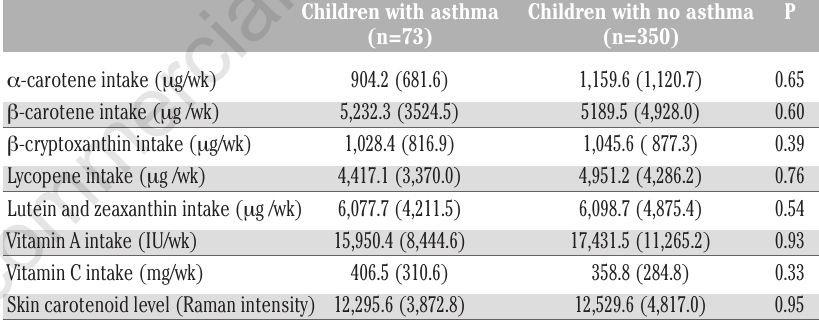
Table 2. Dietary carotenoids, vitamin A and C intake. and skin carotenoid level in asth- matic children and control group. Children with asthma Children with no asthma P (n=73)